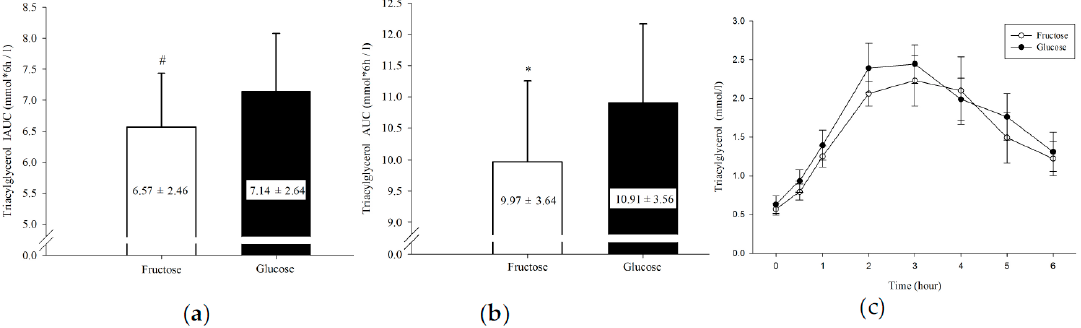
Figure 1. Triacylglycerol (TG) incremental area under the curve ( a ) and TG area under the curve ( b ) in 6 h and postprandial TG concentration over 6 h ( c ). # F was significantly lower than G ( p = 0.004). * F was significantly lower than G ( p = 0.033).